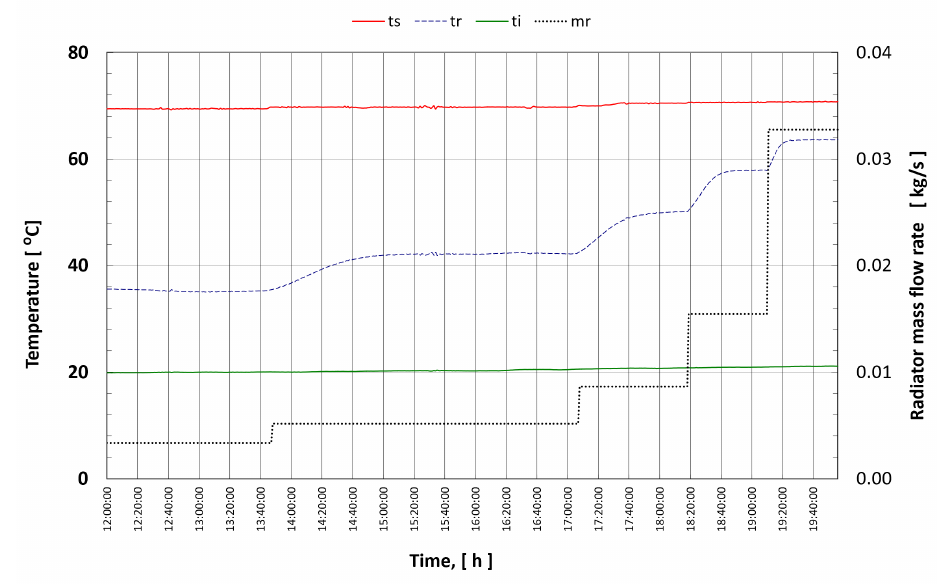
Figure 10. Additional test range, T1 iron element radiator—quantitative. - temperature of the radiator supply water 70.2 ◦ C + − 0.4 K, return temperature from the radiator changed from 35.3 ◦ C to 63.4 ◦